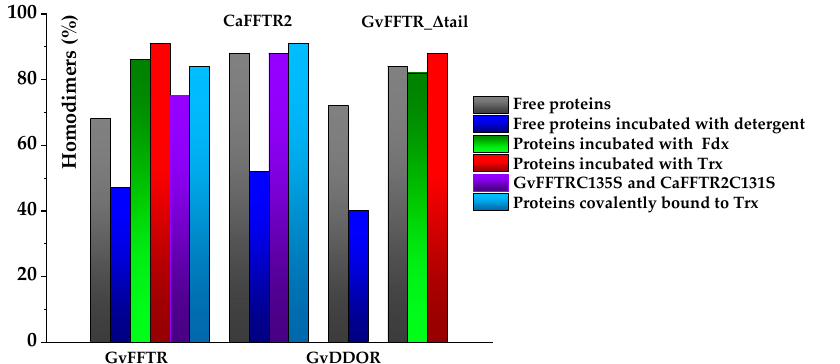
Figure 3. Bar chart representation of percentages of homodimers identified by AFM imaging for GvFFTR, CaFFTR2, GvDDOR, and GvFFTR_ ∆ tail and its mixtures and covalent complexes with protein variants. Color codes for each particular condition are indicated in the right panel. Samples were measured in PBS pH 7.0. Percentages refer to the total of protomers found as homodimers of the flavoprotein (n = 100). When detergent is present, it corresponds to 0.1% SDS/0.2% Tween 20.